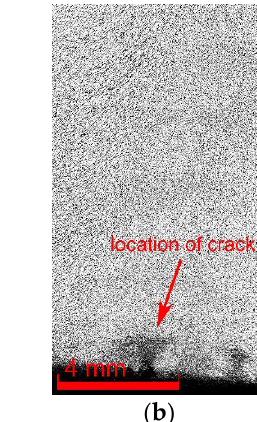
Figure 2. Plastic flow along the axial longitudinal cut through the brass fitting acquired via numerical simulation ( a ); detailed OM view of plastic flow in the vicinity of the crack within the real component ( b ).